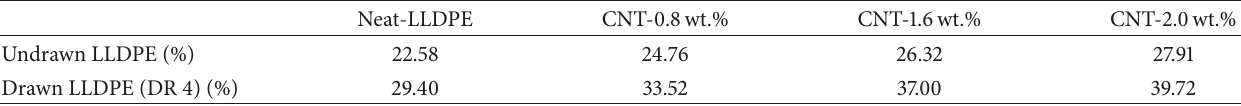
Table 1: Degree of crystallinity of undrawn and drawn LLDPE fibers as a function of CNTs content. Neat-LLDPE